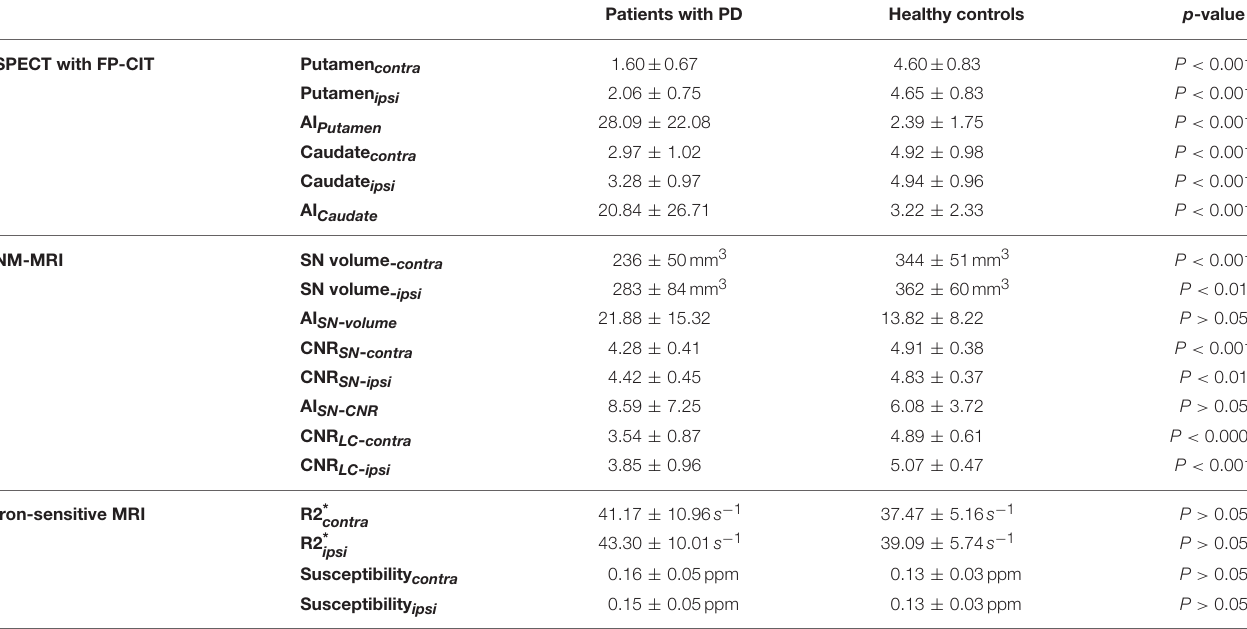
TABLE 1 | Brain imaging findings in patients with PD and healthy